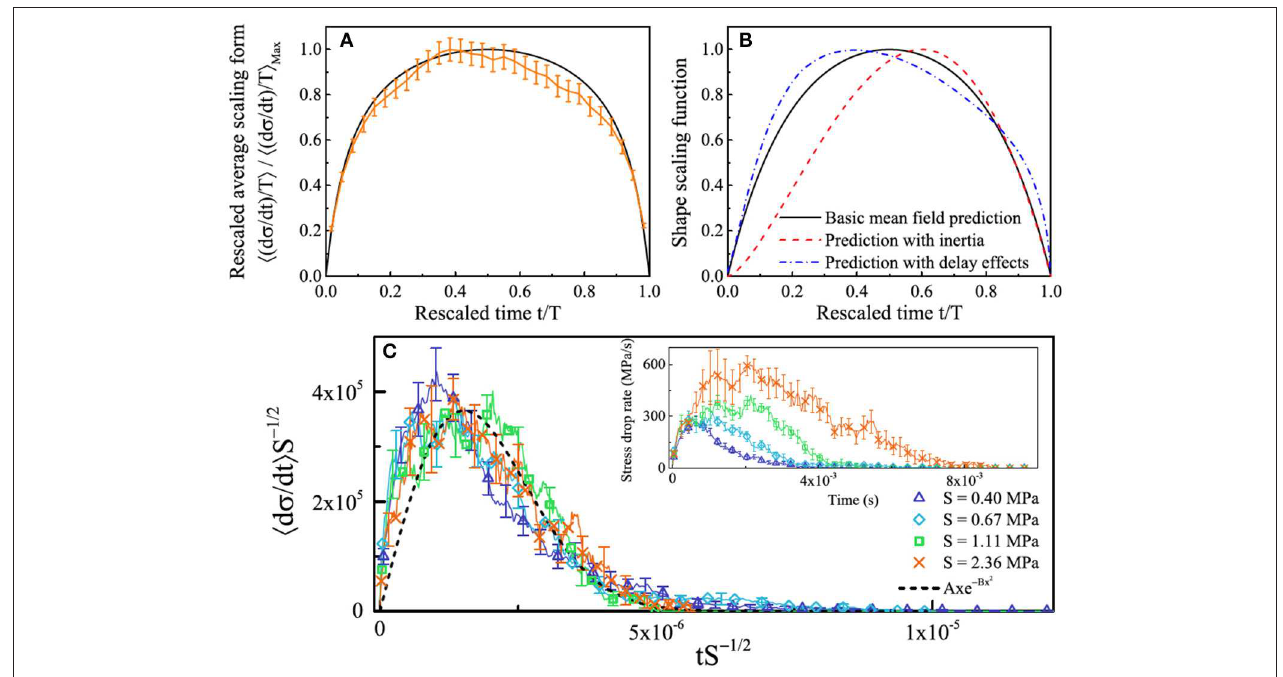
FIGURE 6 | Average avalanche profiles of “small” avalanches. (A) Orange curve: Stress-drop rate profiles divided by duration T averaged over all small avalanches in the scaling regime. The model prediction is shown by the black curve. (B) Model predictions for average avalanche profiles for different model assumptions. (C) Inset shows the unscaled average stress-drop rate profiles for different stress-drop sizes S, collapsed in the main figure (scaling both axes by a factor of S − 1 / 2 ). The main figure shows the agreement of the collapse with the predicted collapse scaling function (black curve, for non-universal values of the constants A = 3.98 × 10 11 and B = 2.18 × 10 11 ) [Reprinted with permission from Antonaglia et al. [6] Copyright (2014) by the American Physical Society].